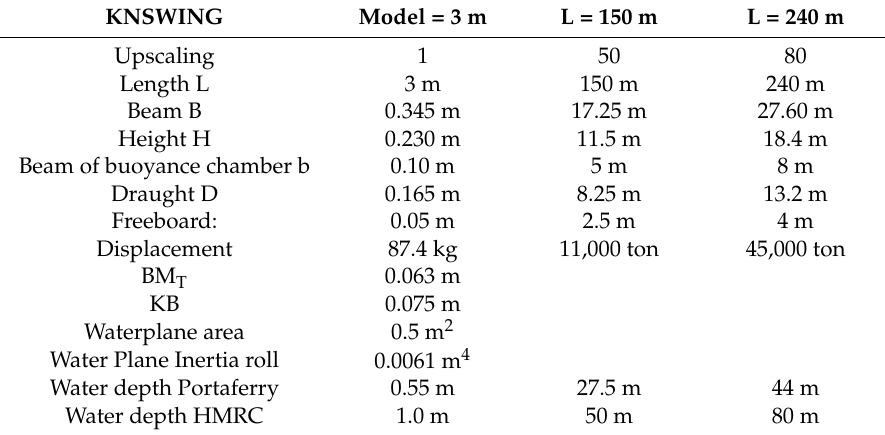
Table 1. Dimensions of the model and scaled-up version of KNSwing.